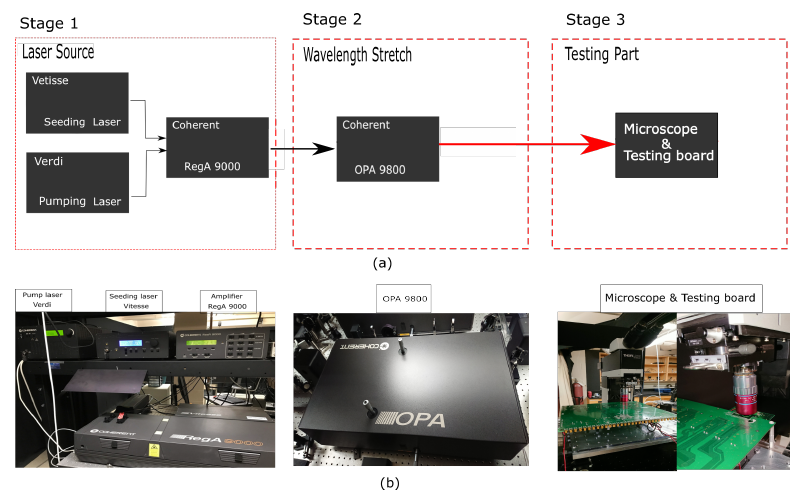
Figure 1. ( a ) Schematic of SEEs testing laser system. ( b ) Real profile of laser system.